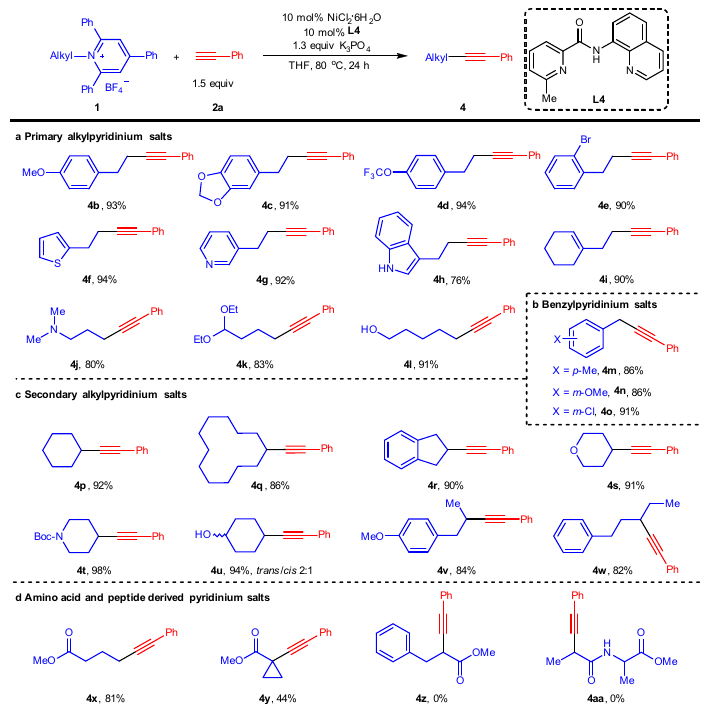
Fig. 3 Scope of alkyl amines. a Scope of primary alkylpyridinium salts. b Scope of benzylpyridinium salts. c Scope of secondary alkylpyridinium salts. d Scope of amino acid and peptide-derived pyridinium salts. Reaction conditions: 1 (0.3 mmol), 2a (0.45 mmol), NiCl 2 ·6H 2 O (10 mol%), L4 (10 mol%), K 3 PO 4 (1.3 equiv), THF (1.5 mL), 80 °C. Isolated yields. For 4g , 4h , 4p , 4q , 4r , 4s , 4t , 4u , 4v , 4w , 4y , 4z , and 4aa , reactions were conducted in DMF (1.5 mL). For 4m , 4n , and 4o , reactions were conducted at 50 °C.